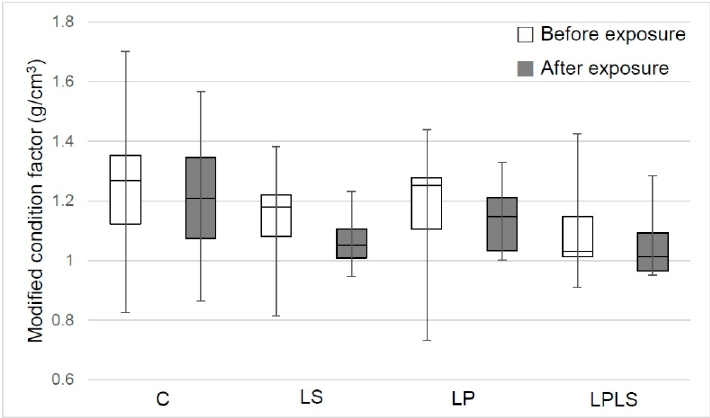
Figure 4. Modified condition factor (CF m ) of each group. The low salinity significantly affected the condition factor). The condition factors before and after treatment are represented by white and gray boxes, respectively, and N are 12, 10, 10, is 11 respectively.